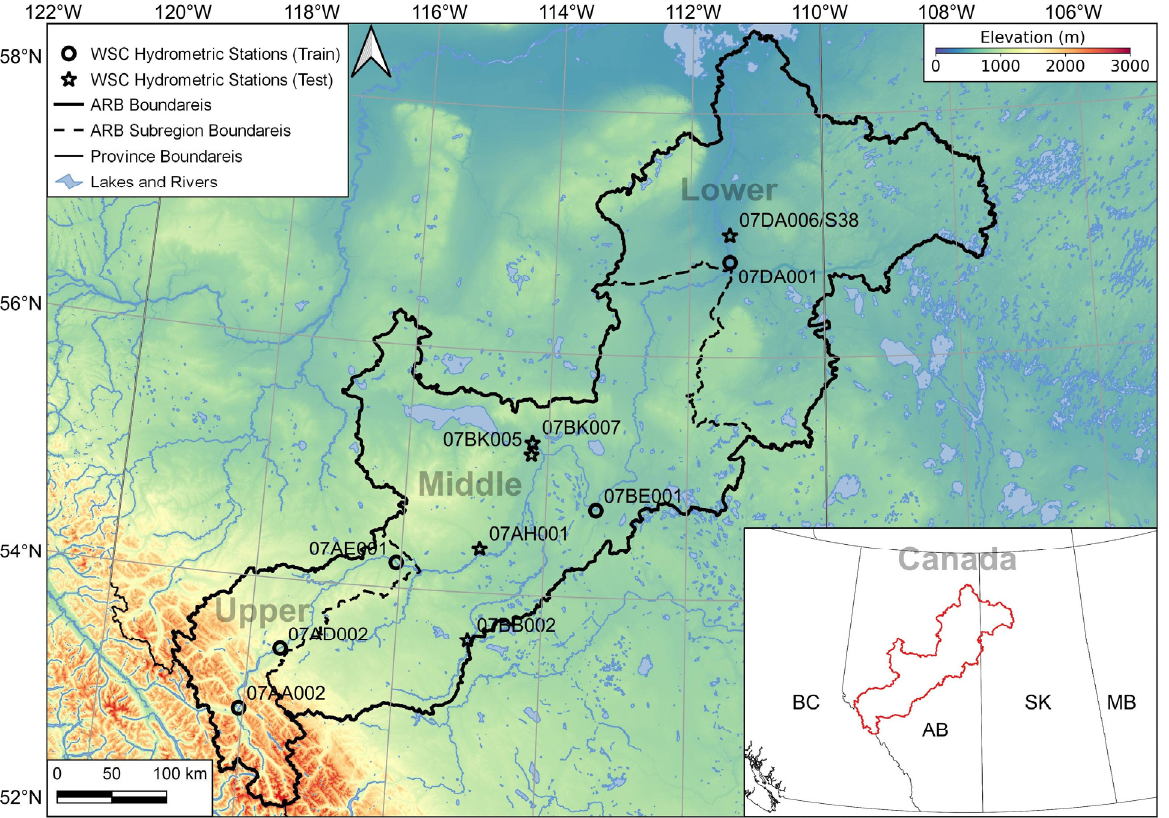
Figure 1. A map of the Athabasca River Basin (ARB). The gradient background color was produced using Shuttle Radar Topography Mission (SRTM) data sampled at 30 m. The right corner window demonstrates the location of the ARB within Canada. Stations selected for training the RSCD algorithm are exhibited with circles, whereas stations selected for testing the algorithm are illustrated with stars.